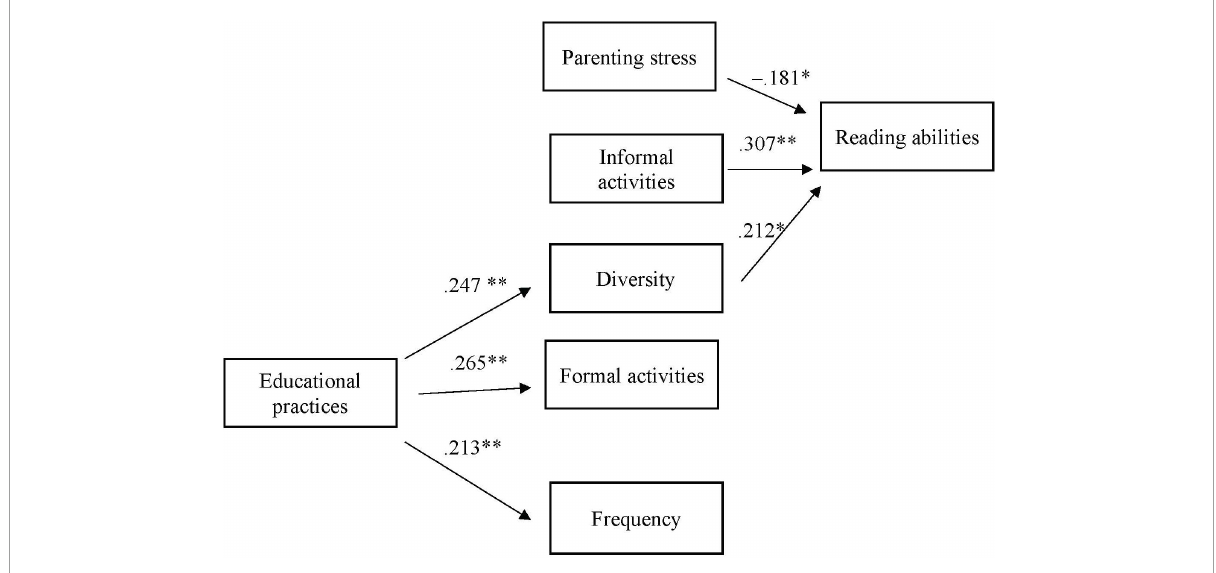
FIGURE3 Explanatory model of reading abilities including familical affective characteristics. ** p < 0.01; * p <